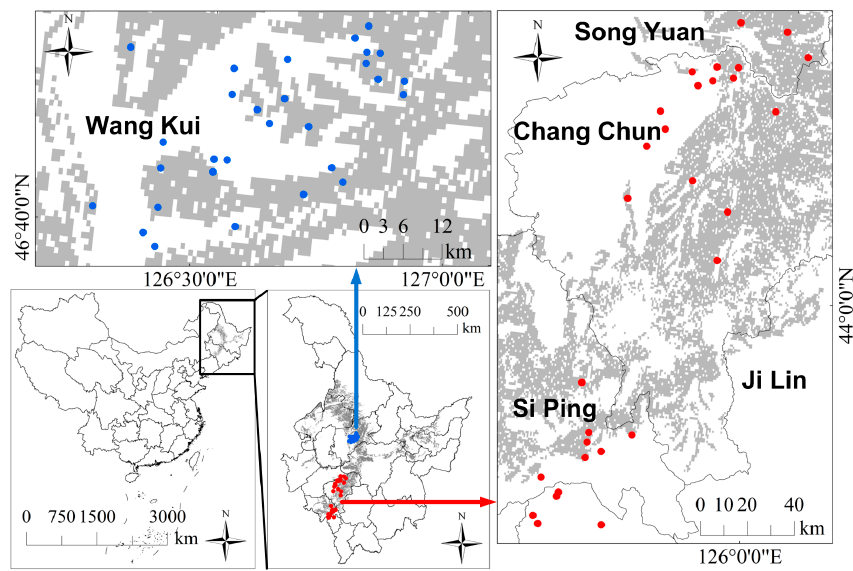
Figure 1. The geographic extent of the sampling sites: dark background indicates the typical black soil area in northeast China. Blue and red points indicate sampling points in Heilongjiang and Jilin.